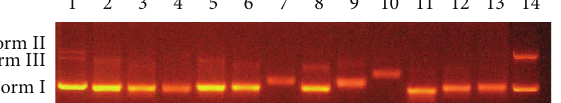
Table 4: Assignments of the selected peaks in 1 H NMR spectra for reaction of complex PtL b Cl